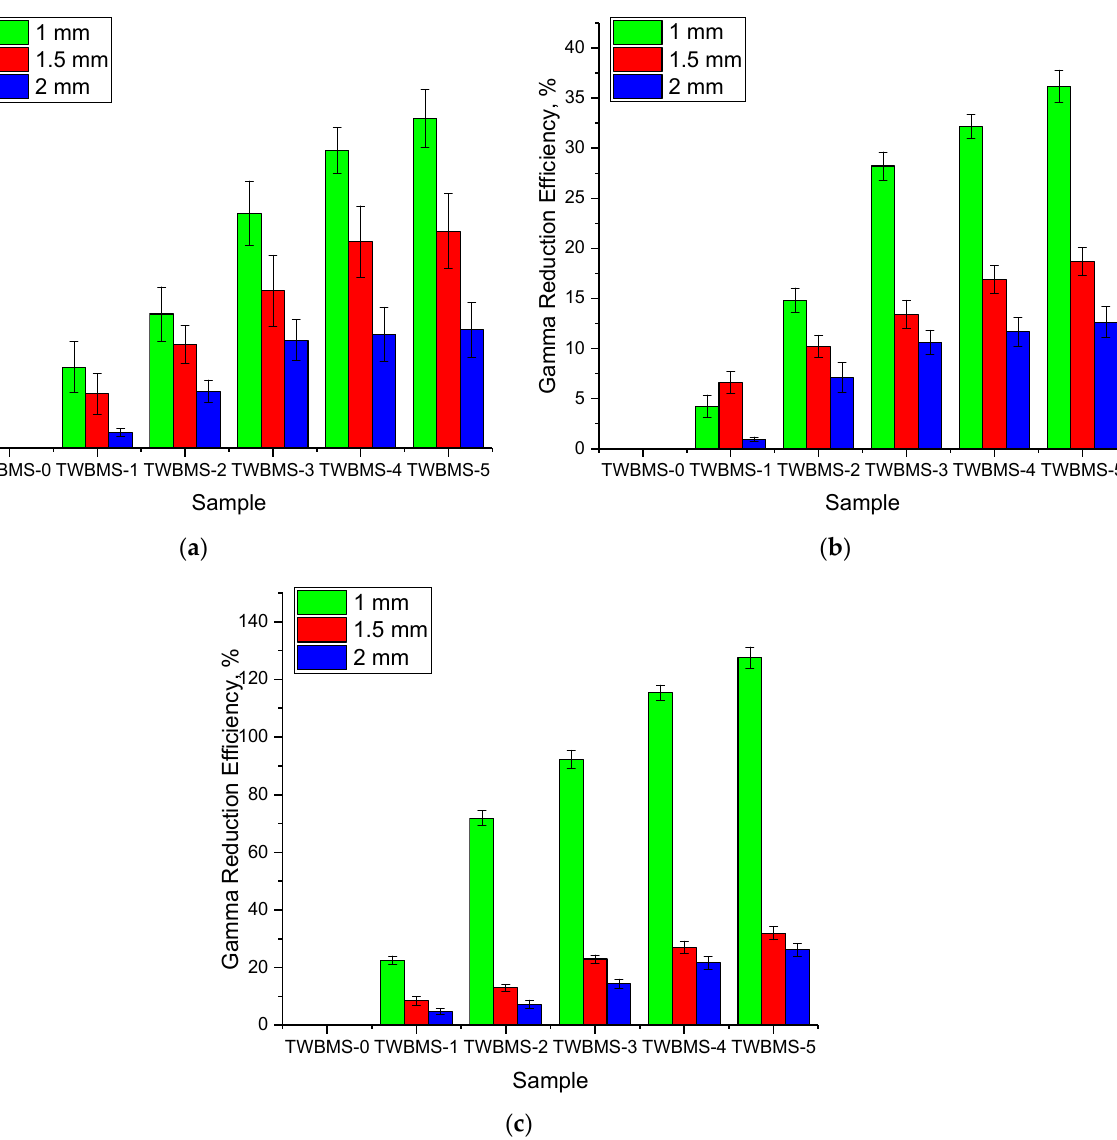
Figure 3. Diagrams of the change in the absorption efficiency of the gamma radiation intensity in comparison with a sample not containing MoO 3 and SiO: ( a ) when shielding gamma rays with an energy of 130 keV; ( b ) when shielding gamma rays with an energy of 660 keV; ( c ) when shielding gamma rays with an energy of 1270 keV.